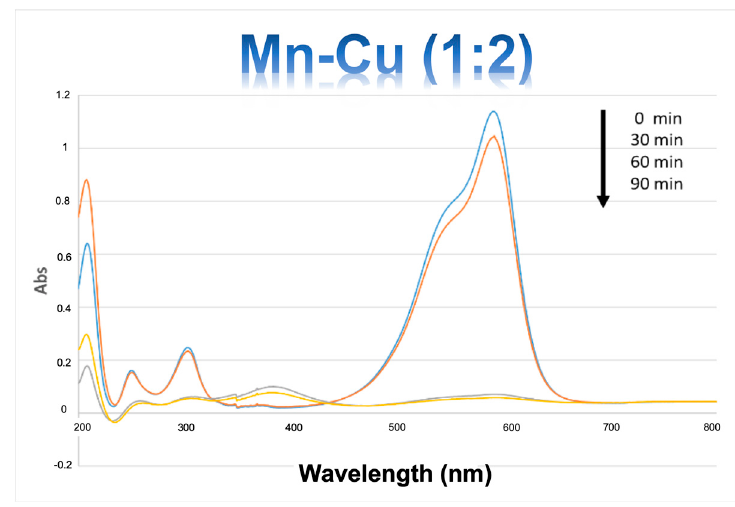
Figure 7. UV-Vis spectra for CWPO of CV with Mn–Cu (1:2) catalyst.